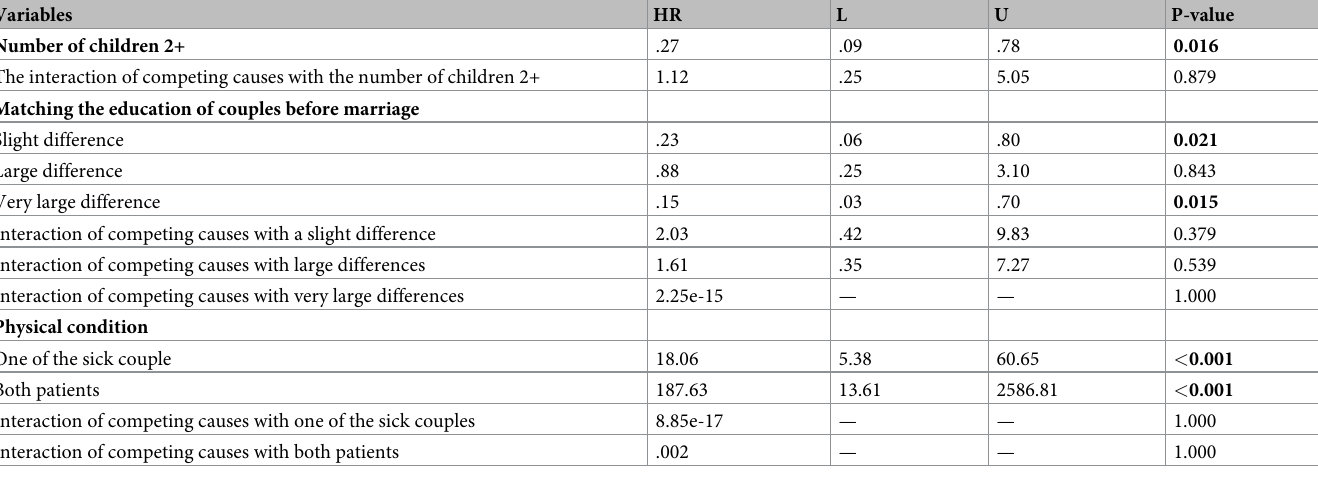
Table 3. Results of Lunn-McNeil multivariate analysis for the competing cause of having a relationship with another